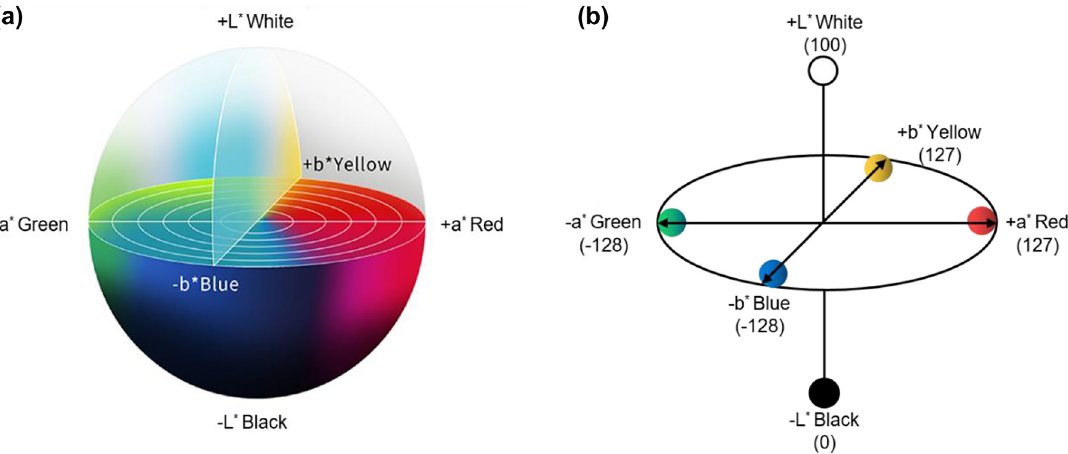
Figure 3: CIE 1976 L ∗ a ∗ b ∗ color space. (a) The CIE 1976 L ∗ a ∗ b ∗ chromaticity diagram. Modified with permission [71]. Copyright 2014, Multidisciplinary Digital Publishing Institute. (b) The L ∗ , a ∗ , and b ∗ values in the CIE 1976 L ∗ a ∗ b ∗ color space. L ∗ represents the color’s brightness level, whose value varies from 0 to 100 as the brightness level increases from black to white. a ∗ and b ∗ represent the color’s chromaticity level, whose values range from − 128 to 127 as the chromaticity level shifts from green to red alone the a ∗ axis and from blue to yellow along the b ∗ axis.